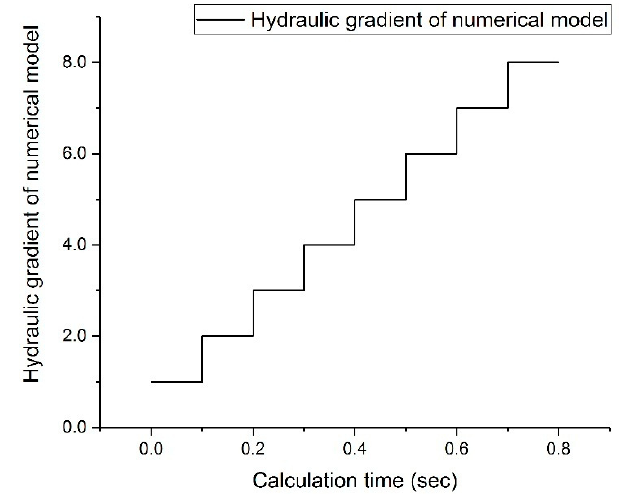
Figure 12. Evolution of the hydraulic gradient applied at the model inlet. Table 1. Model parameter details.